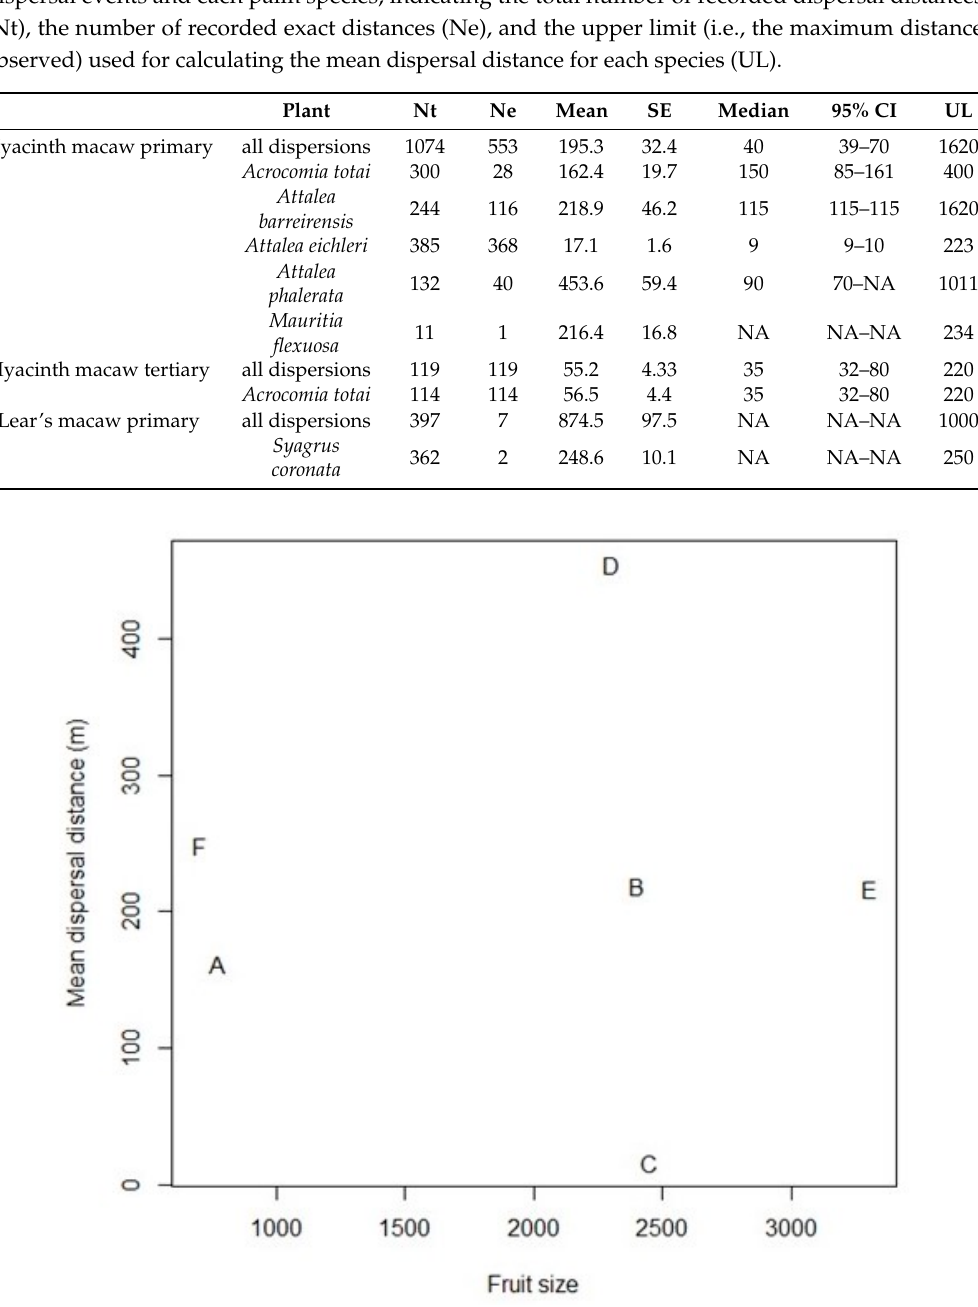
Figure 5. Relationship between estimated mean dispersal distances and fruit sizes (product of